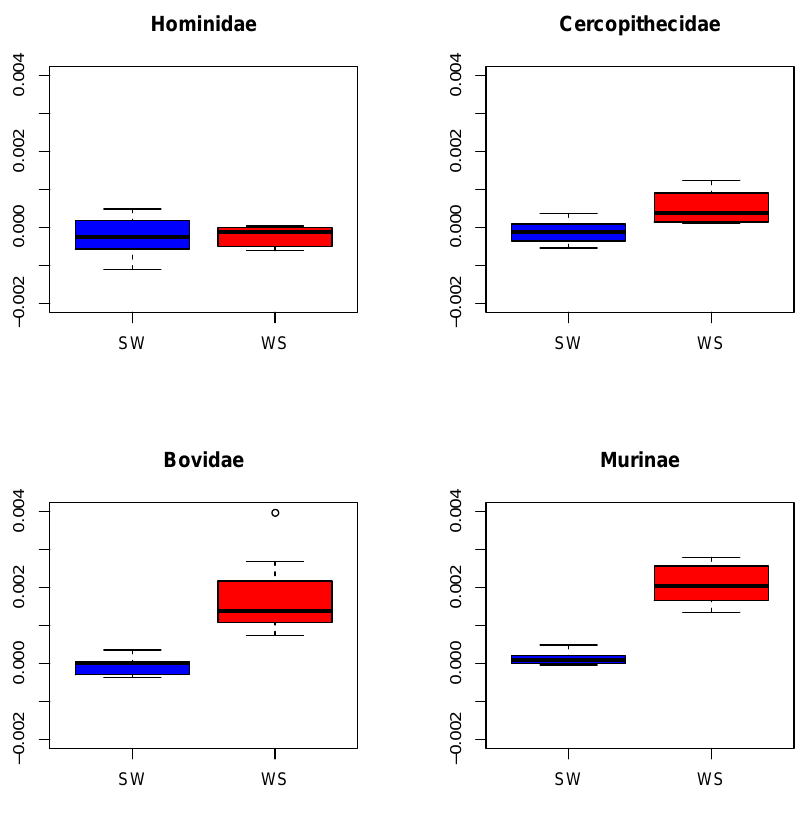
Figure 2 – Distribution of centered Moran’s I for WS and SW synonymous substitutions in four families of mammals. Only branches in which at least 100 genes had at least 3 inferred substitutions were